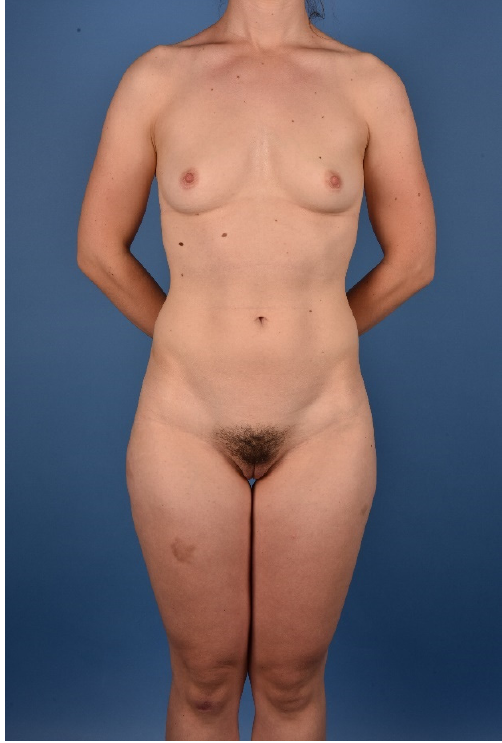
Figure 5. Preoperative image of a BRCA patient.